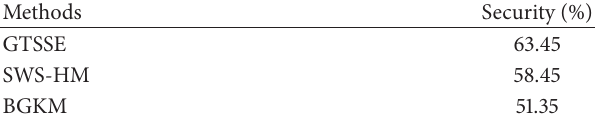
Table 4: Security with respect to GTSSE, SWS-HM, and BGKM.